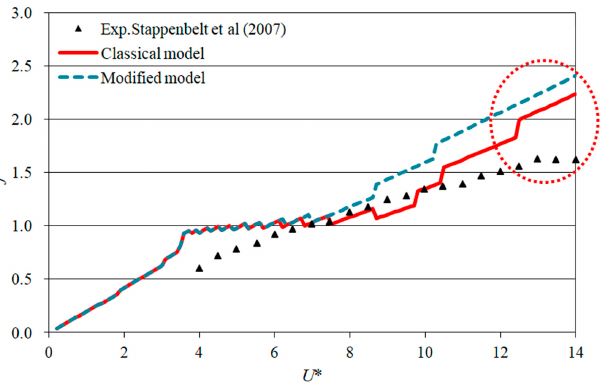
Figure 6. Responses of the vibration frequency versus reduced velocity ( m * = 2.36, m * ζ = 0.014) [14].